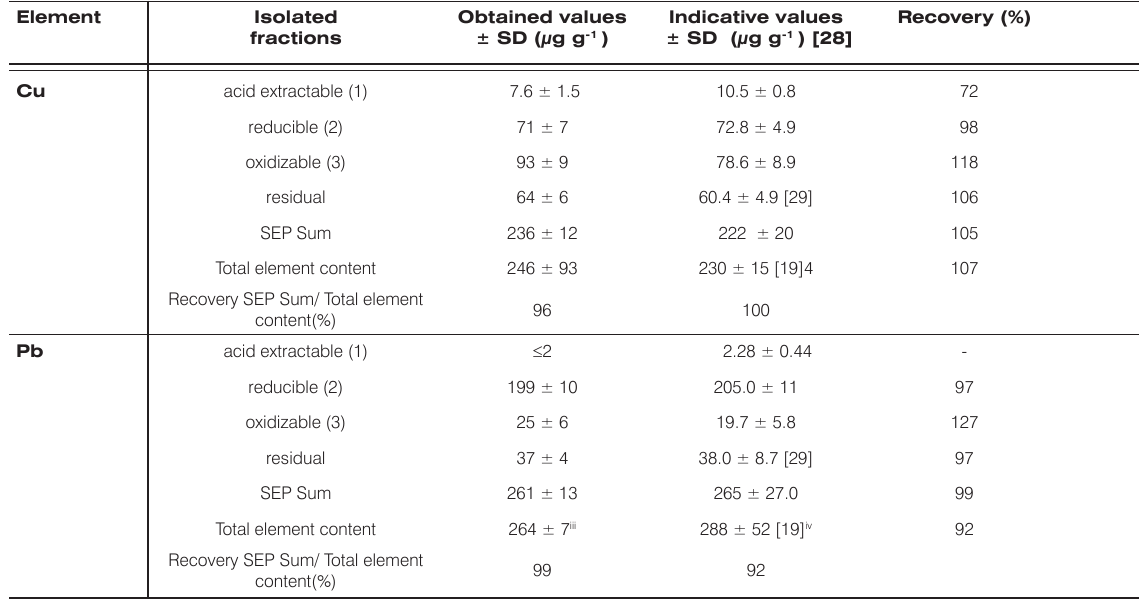
Table 4. Comparison of the obtained and published values of the Cu and Pb extracted contents in the CRM 601 after BCR extraction and the results of total content analysis performed by XRF.